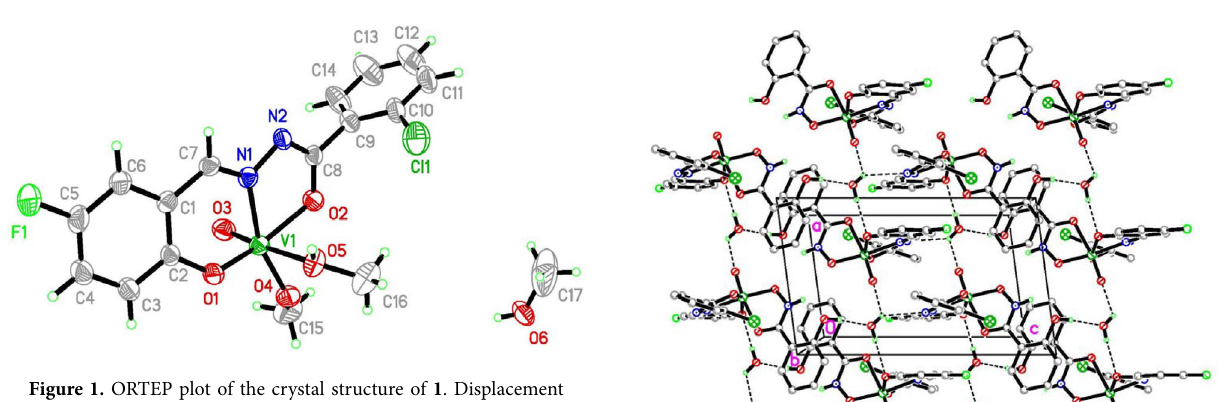
Figure 1. ORTEP plot of the crystal structure of 1 . Displacement ellipsoids of non-hydrogen atoms are drawn at the 30% probability level.